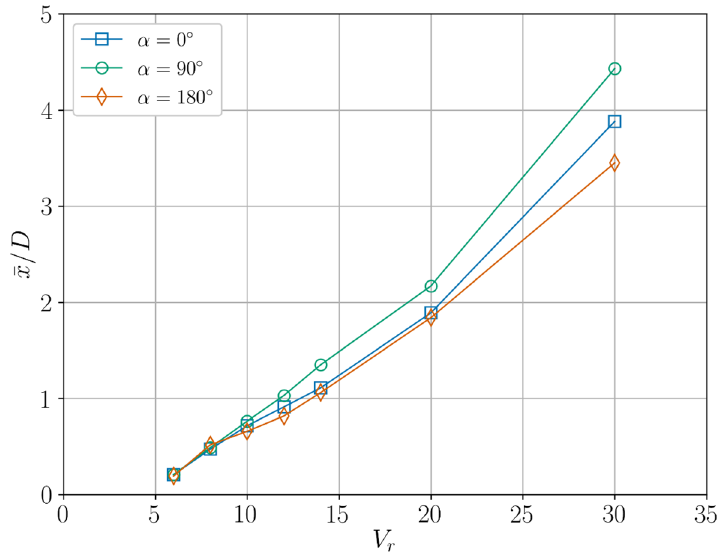
Figure 15. Mean inline response of FOWT platform under different current incidence.